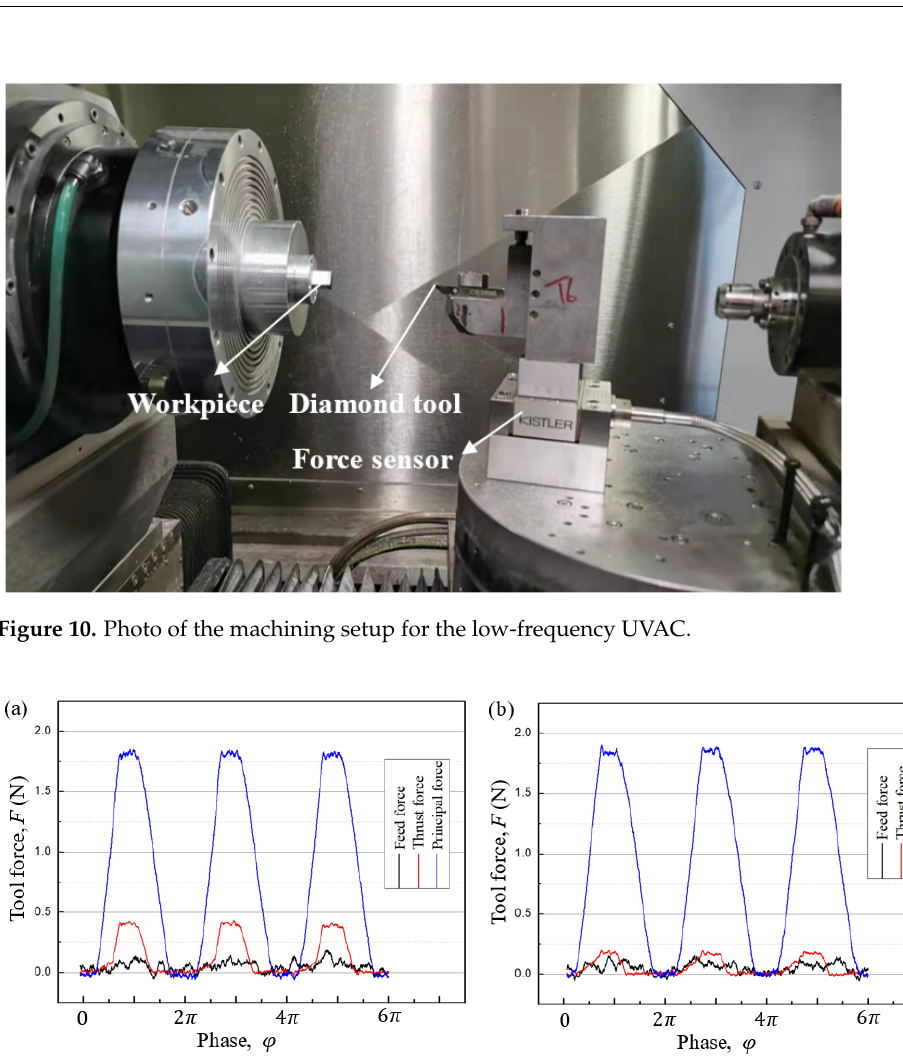
Figure 11. Tool force measured in the programmed grooving tests at various cutting angles: ( a ) 0° and ( b ) 15°, f = 0.5 Hz, A = 1 µ m, v c = 14.4 µ m/min, depth of cut = 5 µ m, and feed rate = 10 µ